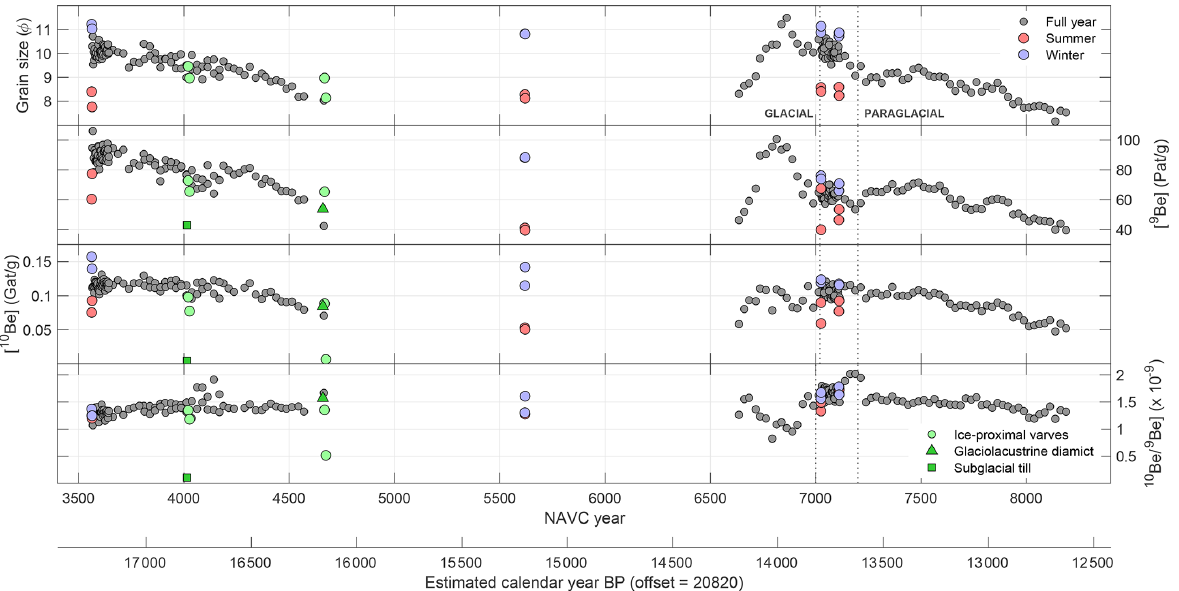
Figure 9. Mean grain size and 10 Be– 9 Be concentrations for all samples, shown in stratigraphic order by NAVC year. Seasonal samples from site 930PN, which is not correlated with the NAVC, are not shown. The boundary between glacial and paraglacial varves is between NAVC 7020 and 7200 but is transitional at many sites and also not isochronous between sections. Error bars are not shown for